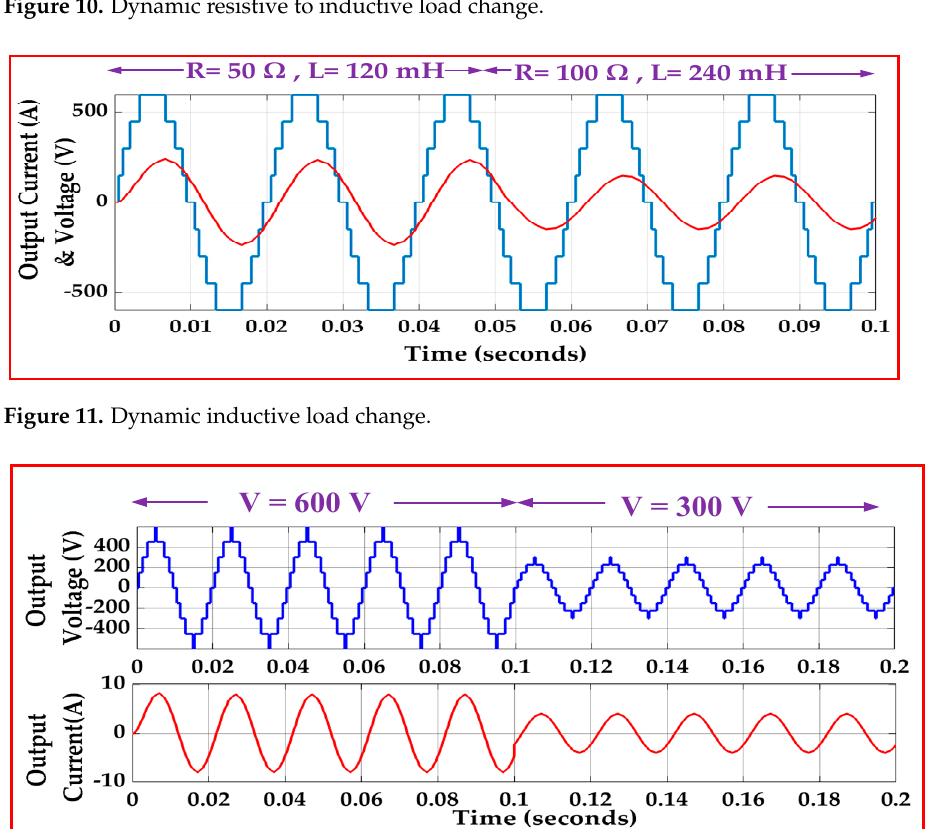
Figure 12. DC voltage source variation.